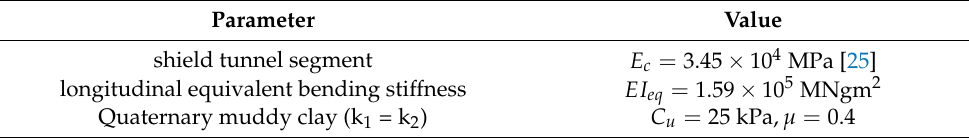
Table 2. Model input parameters for case 2.